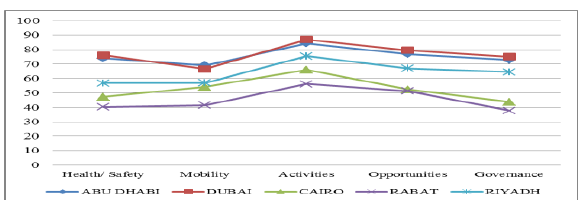
Figure 4: Structures indexes